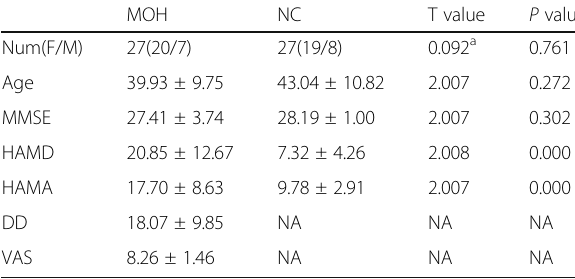
Table 1 The clinical characteristics of the